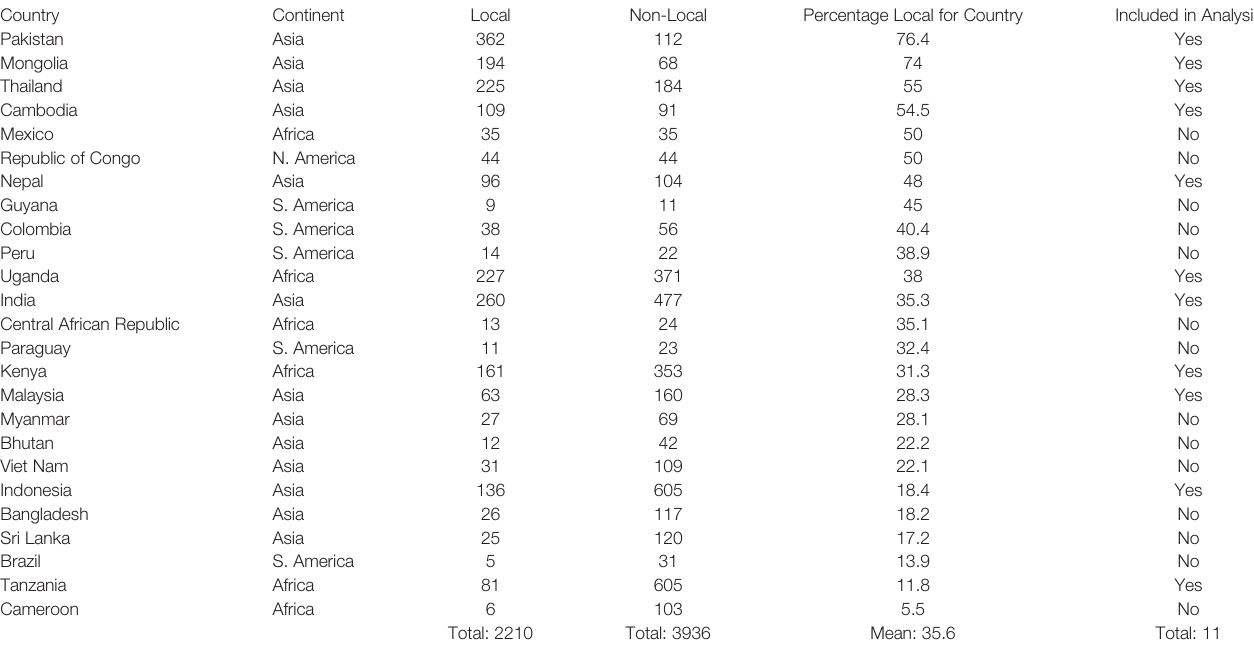
TABLE 1 | Breakdown of local and non-local responses by country. Country